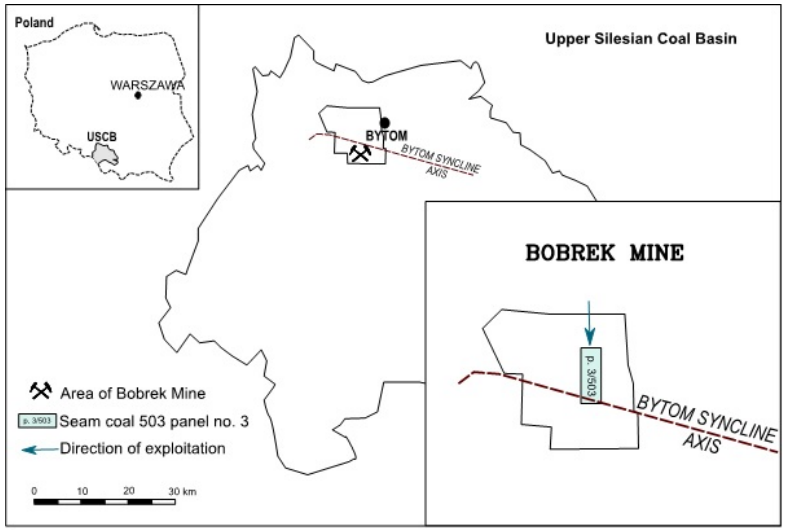
Figure 2. Location of the Bobrek mine area against the background of the Upper Silesian Coal Basin.